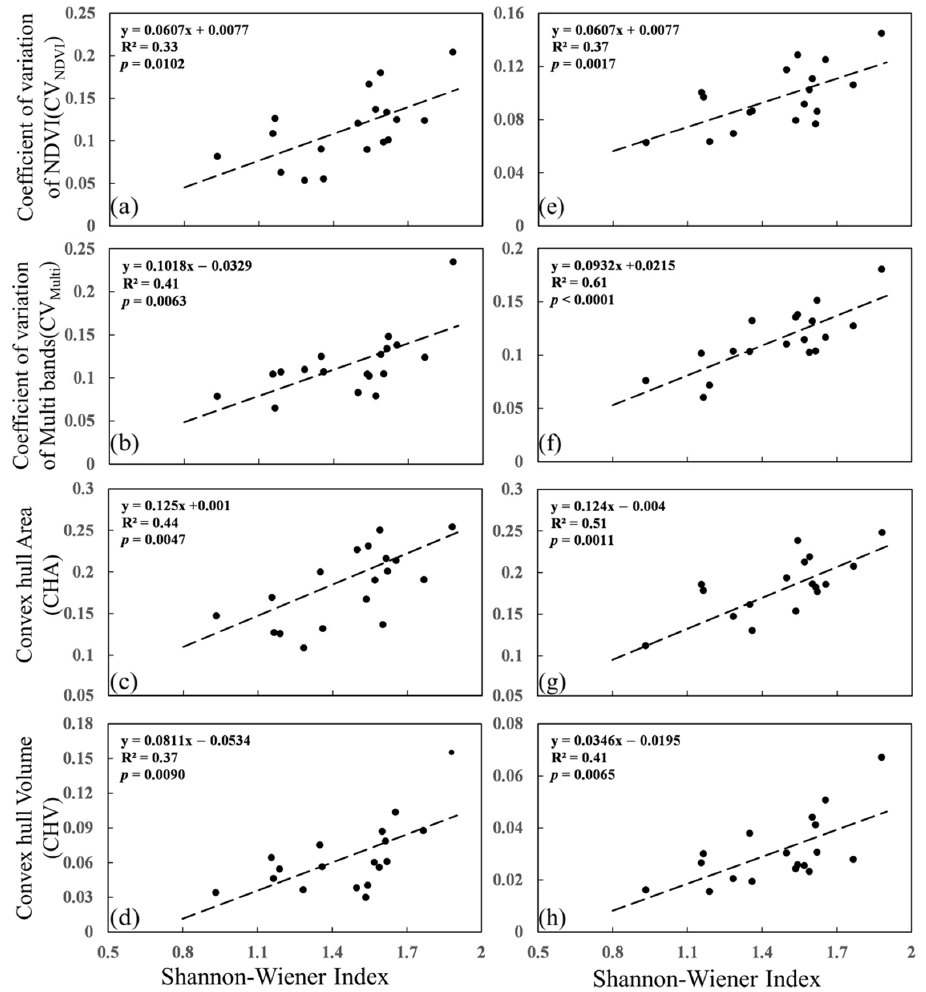
Figure 3. The relationship between Shannon–Wiener index and spectral diversity without soil information. The left column indicates the relationship between Shannon–Wiener index and four spectral diversity metrics after removing the soil based on the NDVI threshold (NDVI threshold is 0.4. ( a – d ); The right column represents the relationship between Shannon–Wiener index and four spectral diversity metrics after removing the soil based on the linear spectral unmixing model ( e – h ).